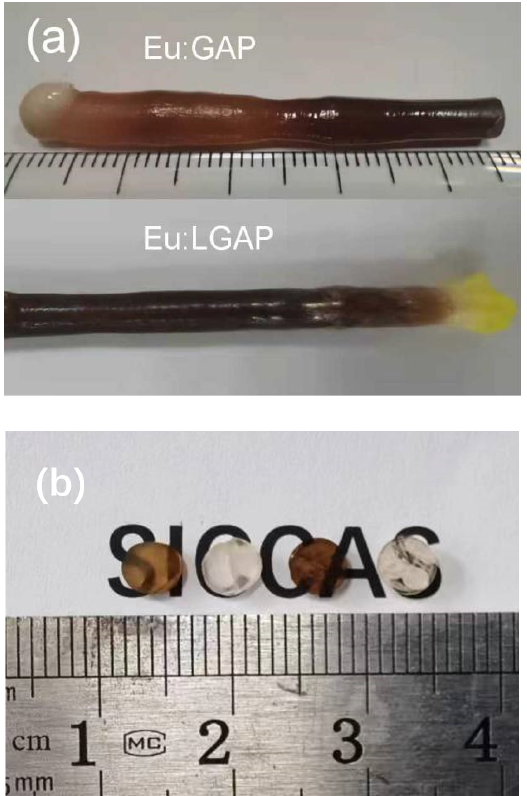
Figure 1. Photographs of the ( a ) as-grown Eu:GAP and Eu:GLAP crystal rods; ( b ) double face polished Eu:GAP and Eu:GLAP single crystals, from left to right, as-grown Eu:GAP and annealed Eu:GAP crystals, as-grown Eu:GLAP and annealed Eu:GLAP crystals, 1 mm thickness.